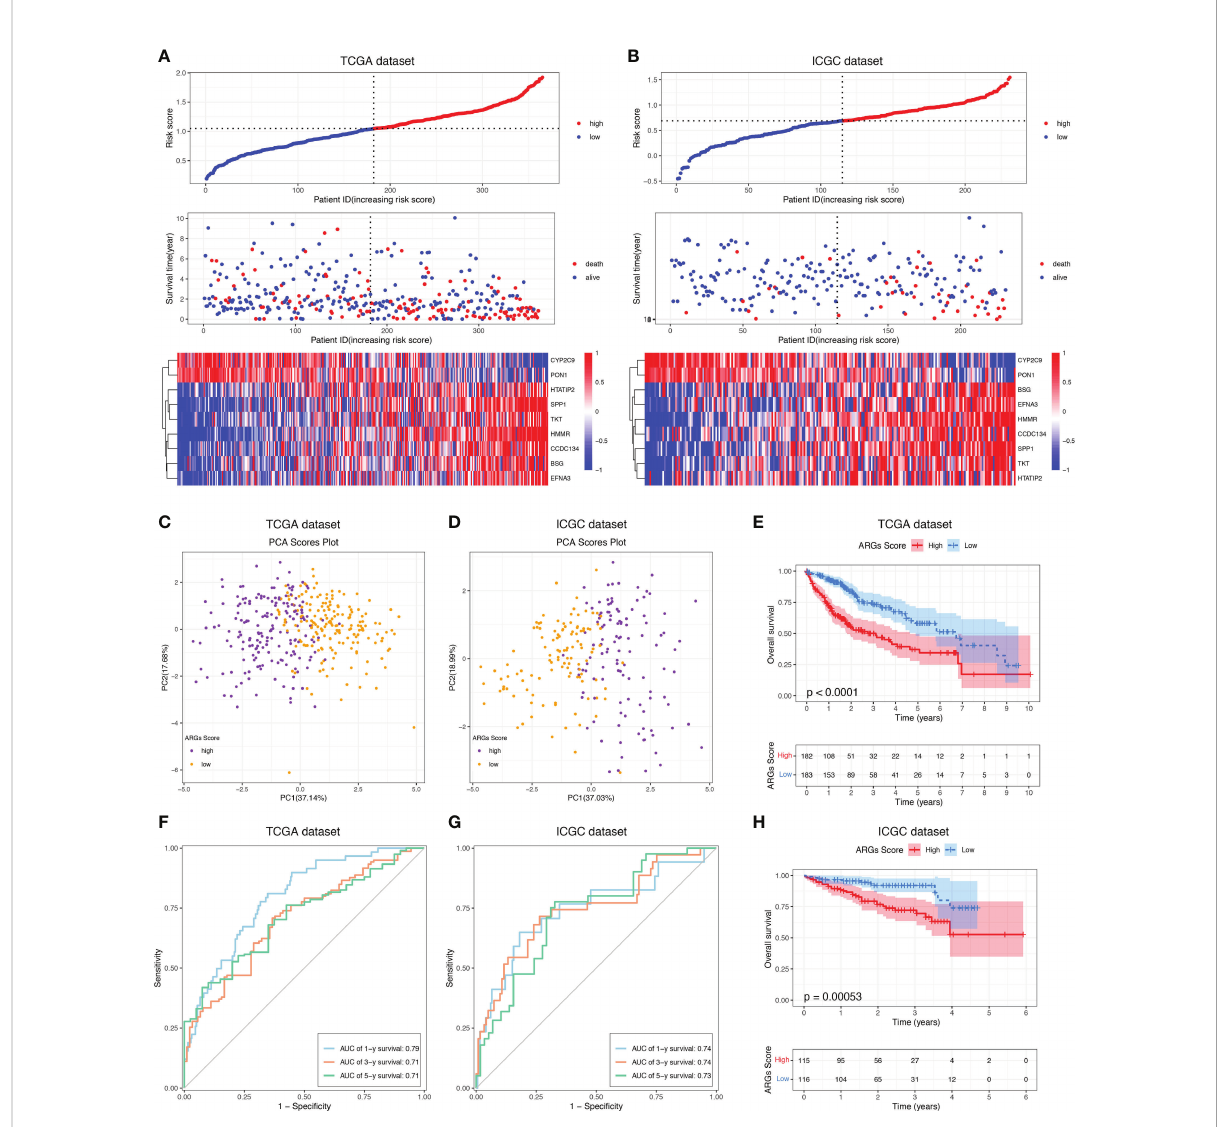
FIGURE 5 Construction and validation of the ARGs Scoring model. The distribution of the ARGs Score, survival status and ARGs expression of HCC patients in the (A) TCGA and (B) ICGC cohorts. PCA analysis of the HCC patients based on the ARGs Score in the (C) TCGA and (D) ICGC cohorts. KM analyses of the ARGs Score in the (E) TCGA and (H) ICGC cohorts. Time-dependent ROC curve of the ARGs Score in the (F) TCGA and (G) ICGC